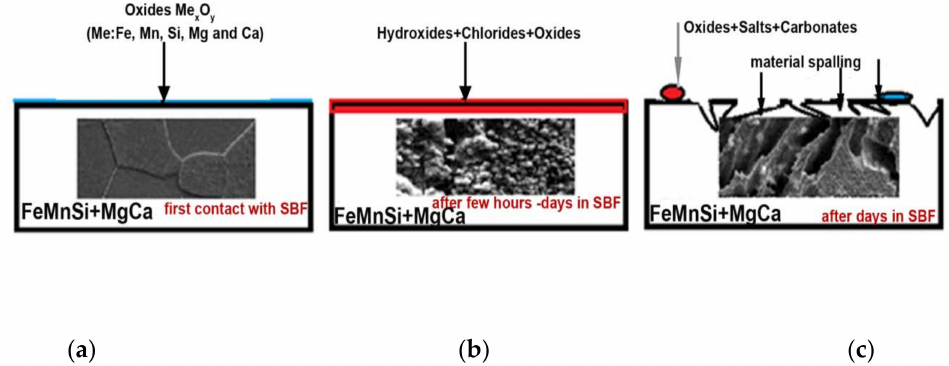
Figure 8. Growth of oxide/hydroxides/carbonates multi-layers on the surface of the FeMnSi–MgCa alloy in strength contact with SBF. ( a ) Initiation of corrosion; ( b ) after a few hours; and ( c ) after a few days in SBF